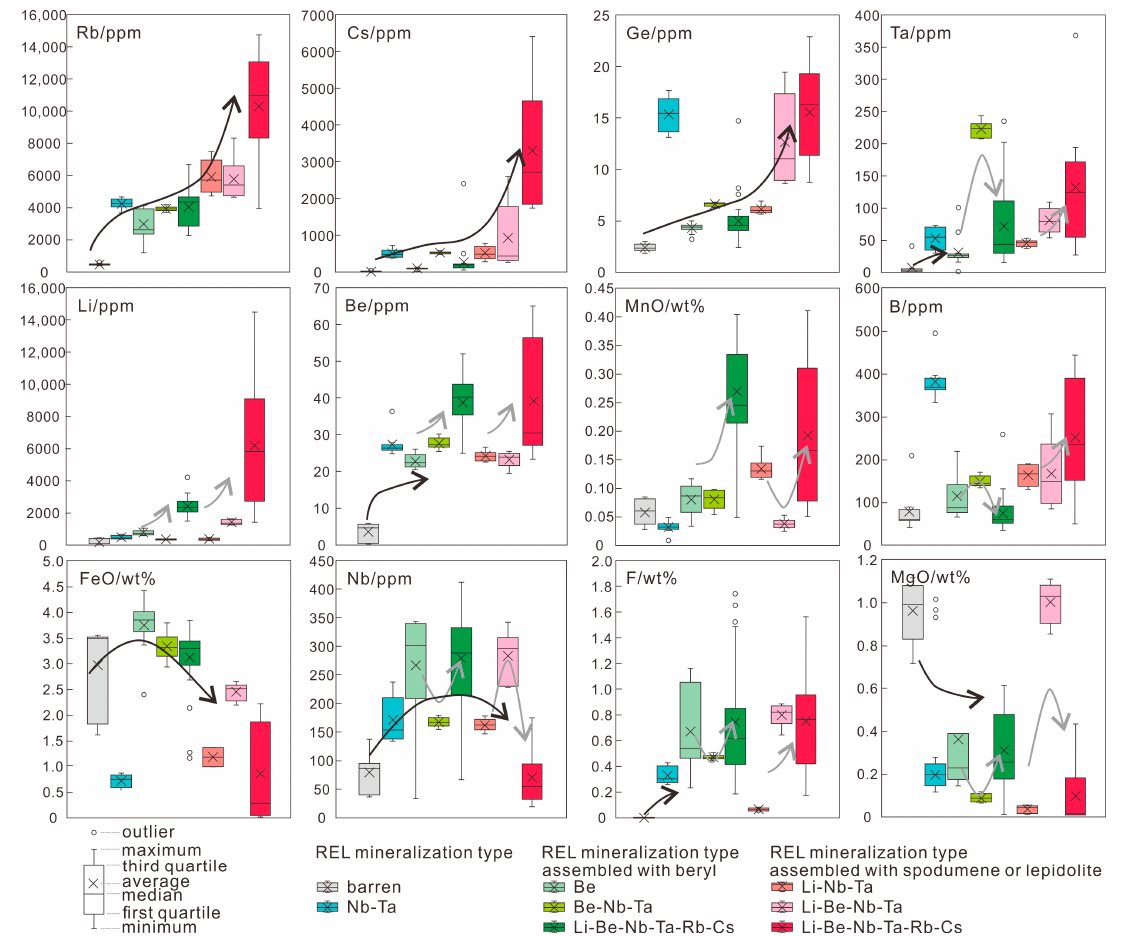
Figure 7. Whisker-box diagrams of variations of Rb, Cs, Ge, Ta, Nb, Li, Be, B, F, FeO, MnO and MgO contents, showing compositional trends of muscovites from pegmatites with diverse REL mineralization types. The Koktokay No.3 pegmatite represent the Li-Be-Nb-Ta-Rb-Cs mineralization type and zones I–IV and V–VIII are related to those assembled with beryl and spodumene/lepidolite, respectively. The data of muscovites of the Koktokay No.3 pegmatite are from [45,100]. The black and grey arrows represent trends of changes from barren to Li-Be-Nb-Ta-Rb-Cs pegmatite and among beryl-bearing or spodumene-bearing pegmatites,